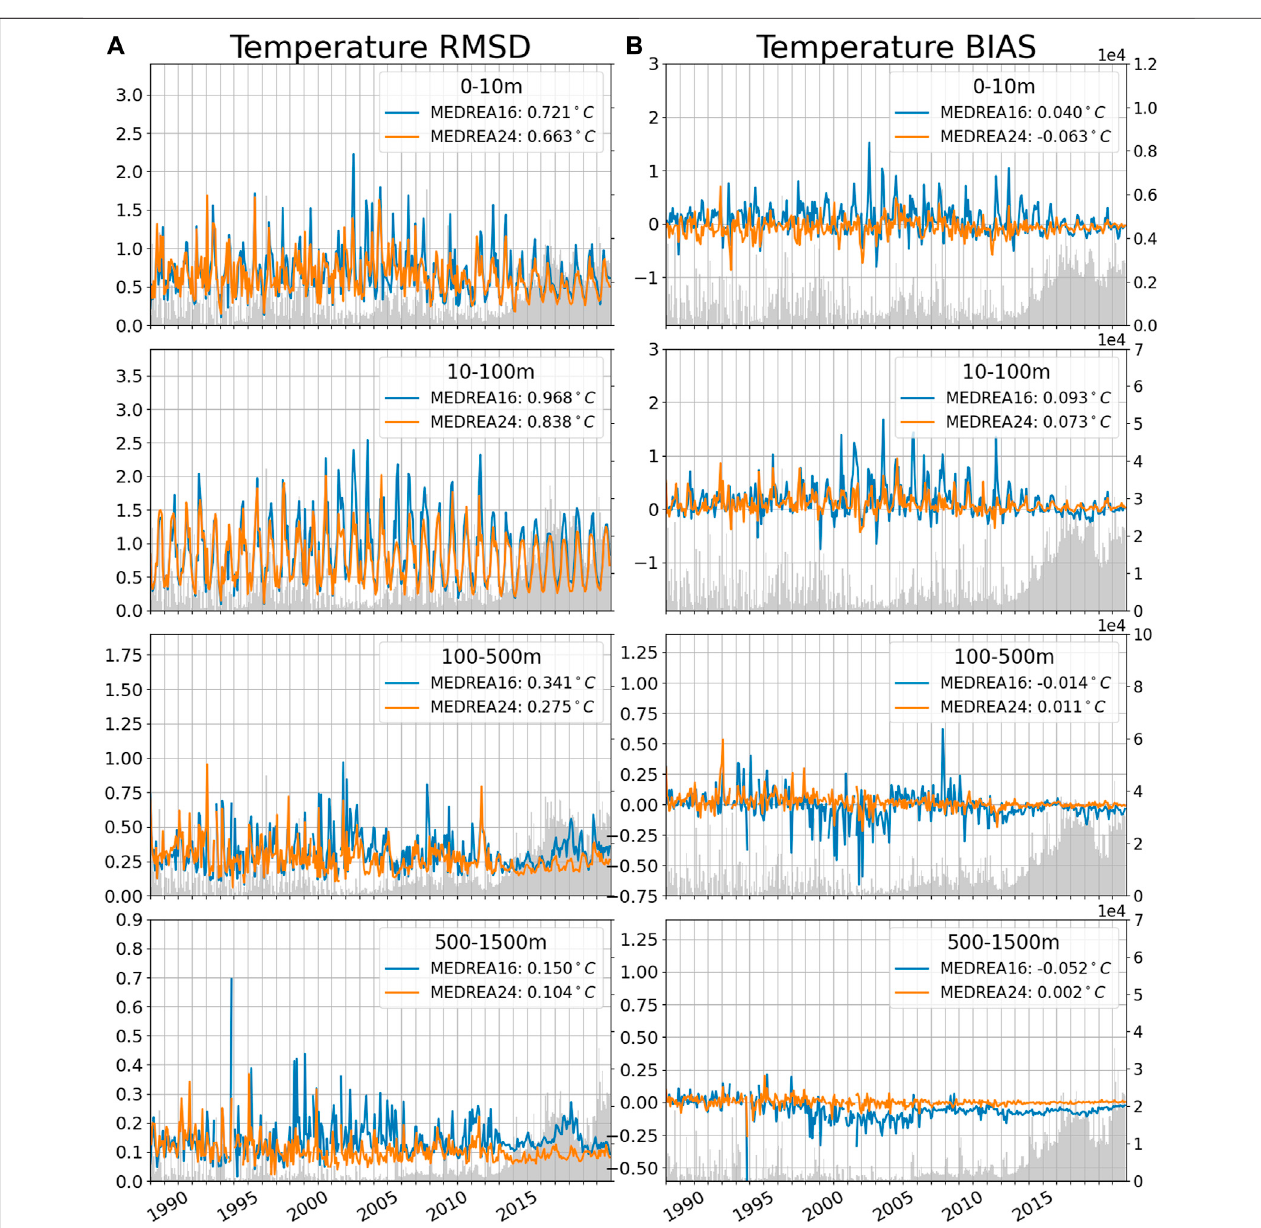
FIGURE5| MonthlytemperatureRMSD (A) andbias (B) (in ° C )forthetworeanalysesandthehindcastwhencomparedtoobservedpro fi lesfordifferentlayers.The values of RMSD/bias for the whole period are indicated in the legend. The shaded area represents the number of observations for each month (axis is on the right). Note the different y -axis in the different layers.